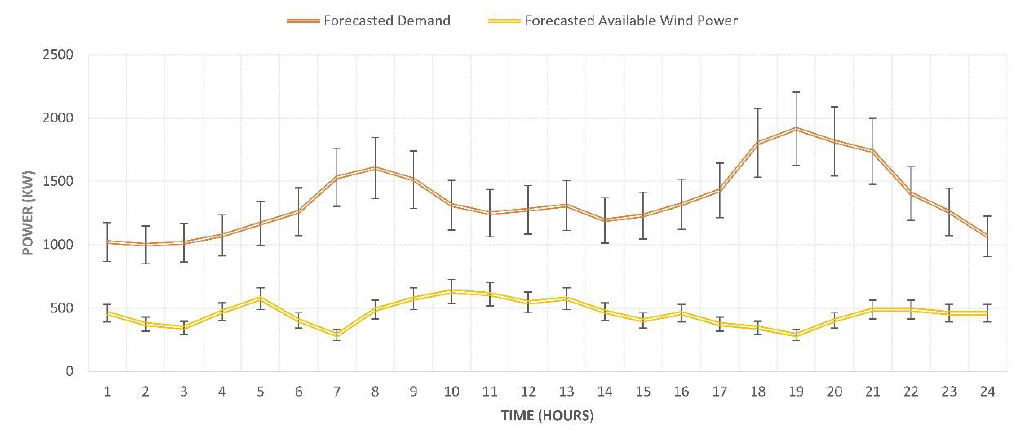
Figure 6. Forecasted wind power and demand.